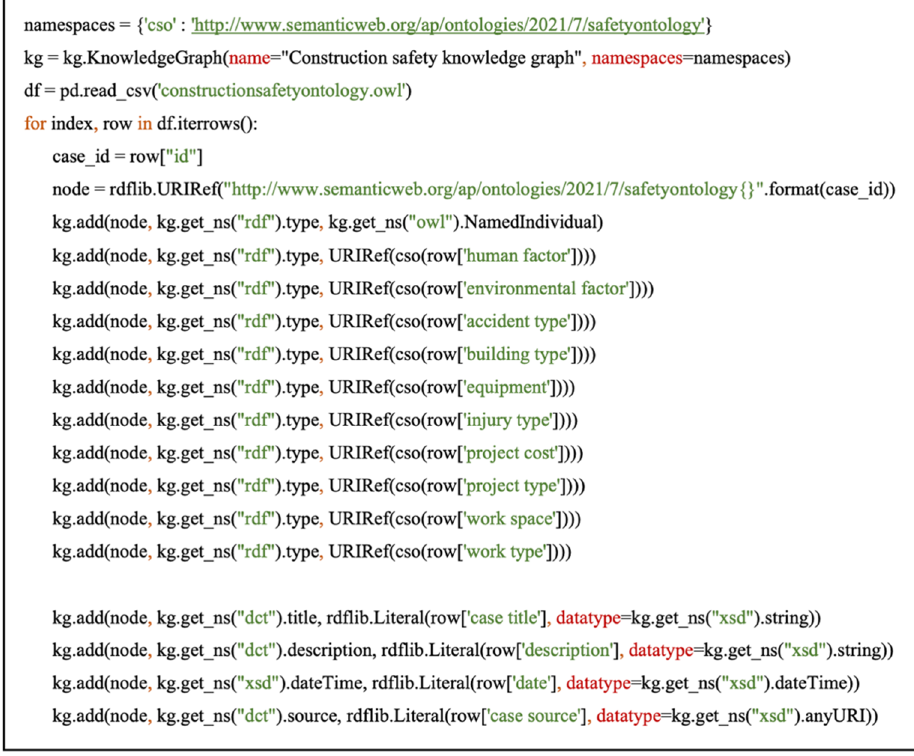
Figure 7. Algorithm for automatic conversion of accident data to RDF.